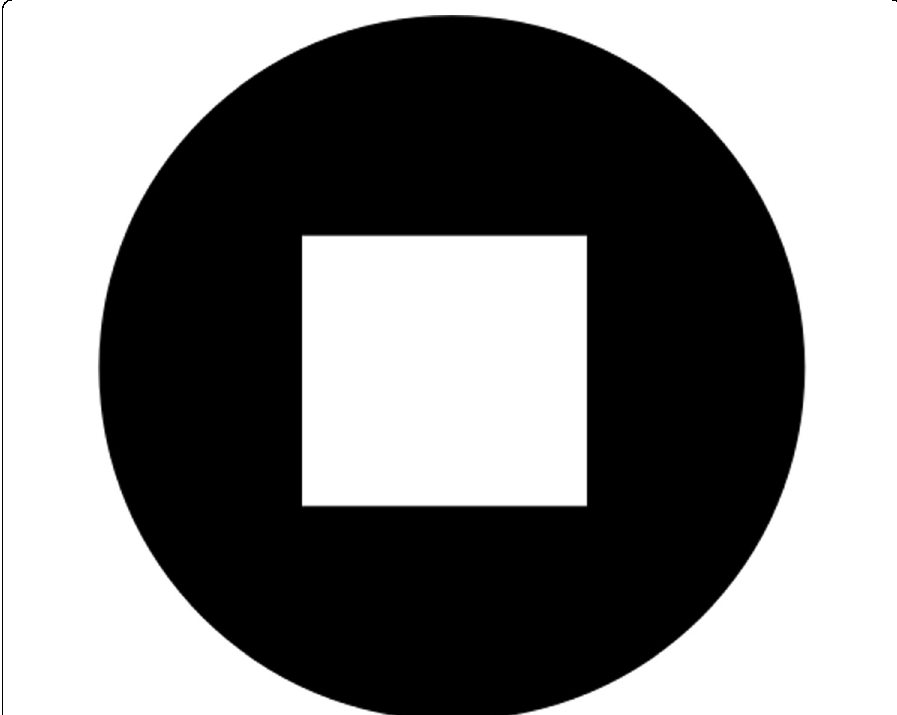
Fig. 22 Legend: The square presents the learner, the black surface presents the platform. Together, they show how the platform forms a mold around the learner and composes a figure, similar to a Gestalt